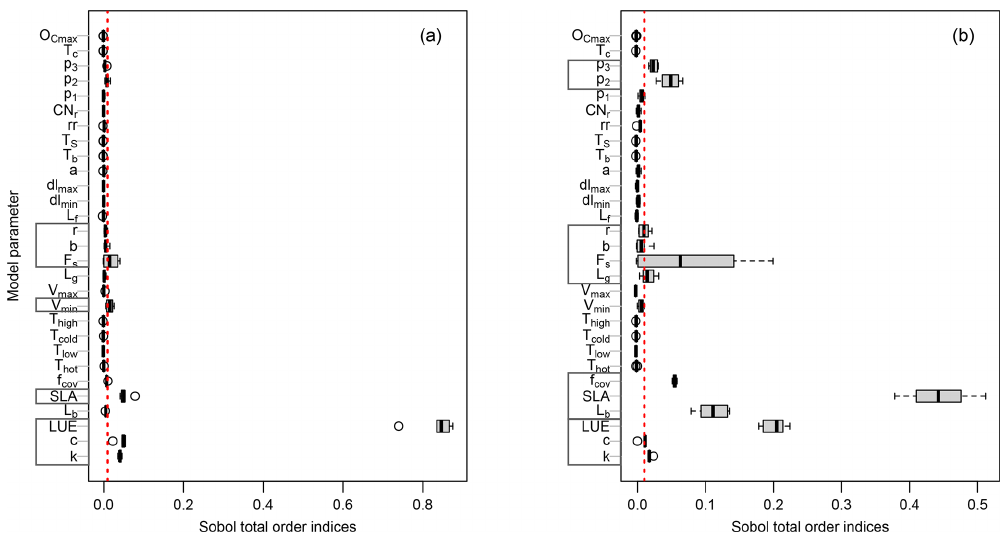
Figure 3. Distribution of the total-order Sobol’ indices for GPP (a) and LAI (b) outputs across all sites. Each gray box on the y axis represents parameters involved in a specific process as follows: GPP-related parameters (Eqs. 3 and 4); LAI-related parameters (Eqs. 2 and 26); environmental stresses-related parameters (Eq. 10); phenology-related parameters (Eqs. 18, 20, and 22); canopy respiration-related parameters (Eq. 17). The vertical dotted red line corresponds to the threshold of 1%.